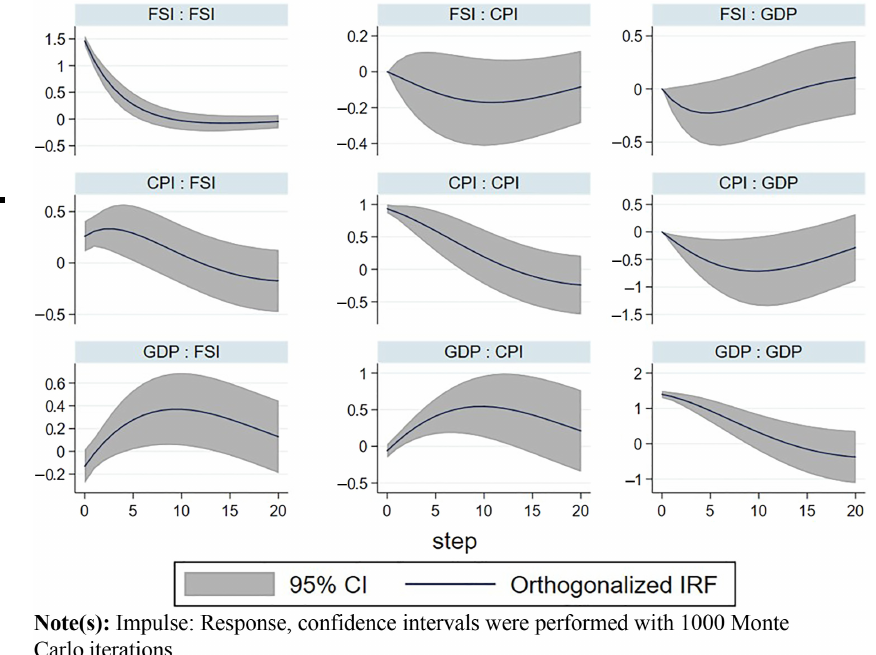
Figure 1. IRFs of the three- variable model for emerging